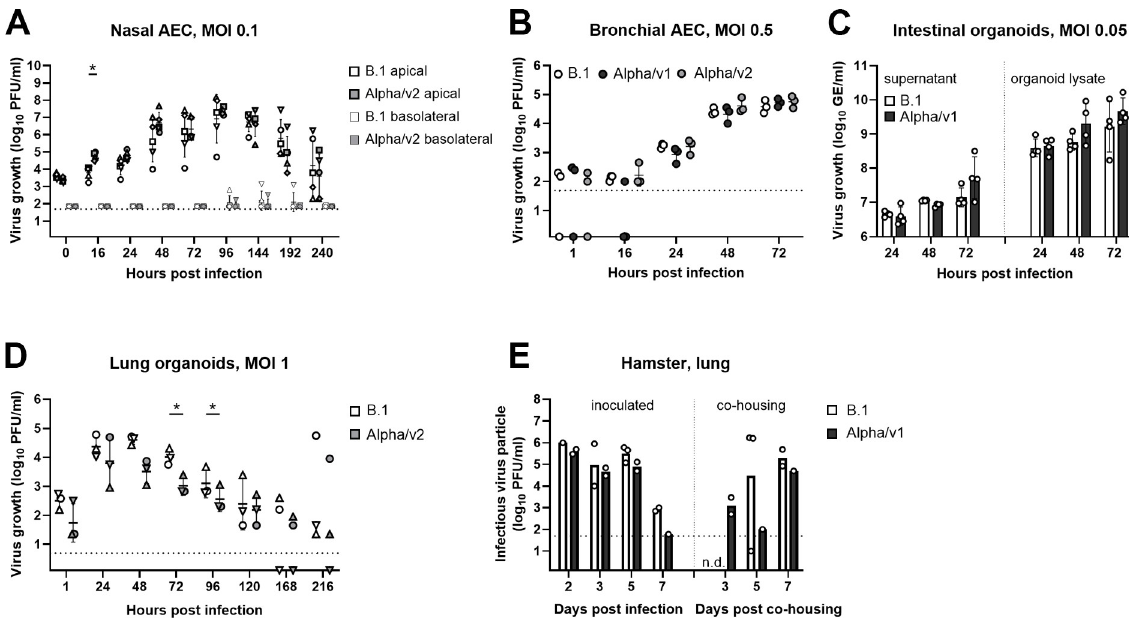
Fig 2. Absence of detectable fitness advantages of VOC Alpha in primary human respiratory cells, organoids, and hamsters. ( A ) Virus growth kinetics were performed in infected hNAECs (MOI 0.1). Samples were collected from the apical and basal side at indicated time points and titrated by plaque assay. n = 3 biological replicates. ( B ) Virus growth kinetics was conducted in infected bronchial AEC (MOI 0.5). Samples were collected from the apical side and titrated by plaque assay. Data are derived from 1 experiment conducted in triplicates. ( C ) Intestinal organoids were infected (MOI 0.05) and viral load in supernatant (left) and organoid lysates (right) was quantified at indicated time points by E-gene-specific quantitative RT-PCR. Data are derived from 4 independent experiments. ( D ) Virus replication was monitored in infected lung organoids (MOI 1). Samples harvested at indicated time points were titrated by plaque assay. Data are derived from 3 independent experiments. ( E ) Dwarf hamsters were intranasally infected (100,000 PFU) and infectious virus particles from lung homogenates were quantified using plaque assay (left). Donor hamsters were cohoused with naive animals and transmission efficiency was determined from lung homogenates at the indicated time points (right). n = 1–3 animals per experimental condition. Dotted horizontal lines indicate the lower detection limit of the plaque assays. AEC, airway epithelial culture; GE, genome equivalents; hNAEC, human nasal airway epithelial culture; MOI, multiplicity of infection; n.d., not detected; PFU, plaque-forming units; RT-PCR, real-time PCR; VOC, variant of concern. See S1 Data.